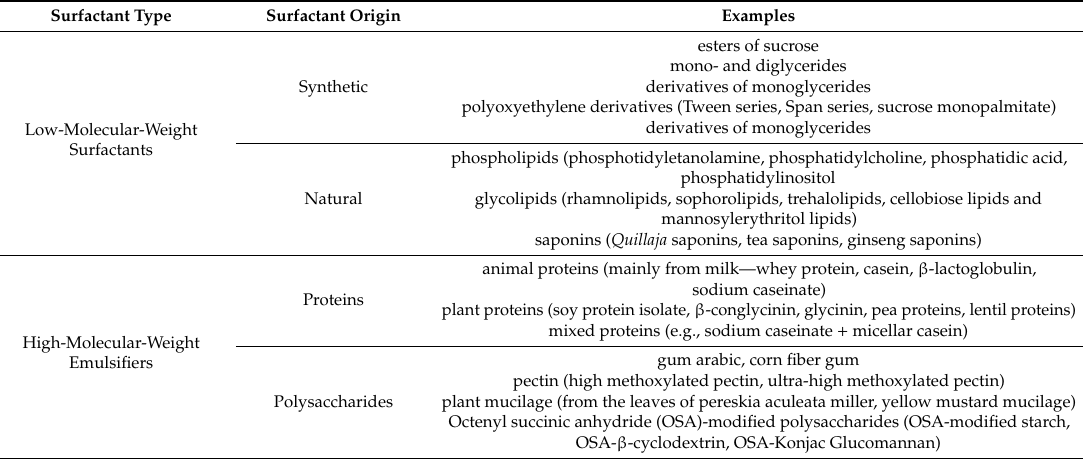
Table 1. Typical emulsifiers used in food nanoemulsions